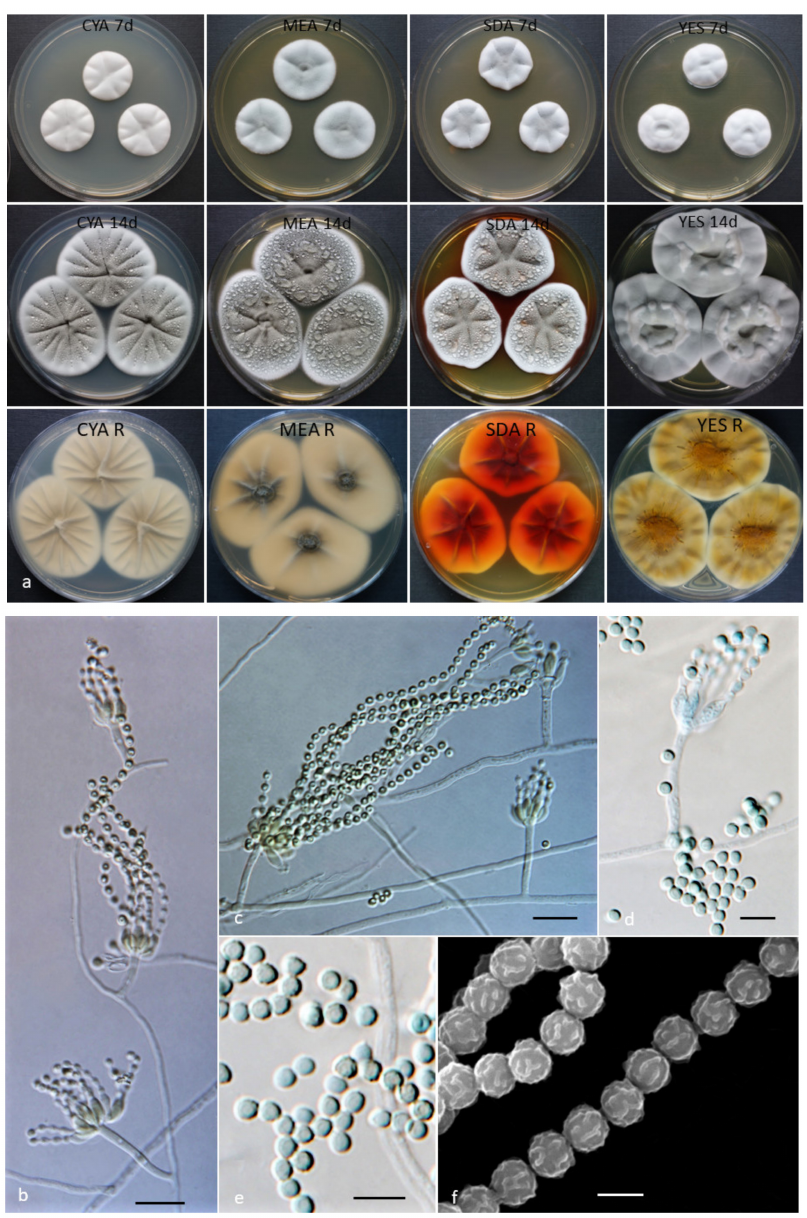
Figure 2. Penicillium silybi G-85. ( a ) Colonies on CYA, MEA, SDA, and YES; rows, from top to bottom: obverses after seven and 14 days, and reverses after 14 days at 25 ◦ C. ( b – d ) Conidiophores with conidia (on MEA, after 25 days); ( e ) conidia (on MEA, after 14 days); ( f ) scanning electron microscopy (SEM) of conidia (on MEA, 20 days). Scale bars = 10 µ m ( b , c ), 5 µ m ( d , e ), 2 µ m ( f